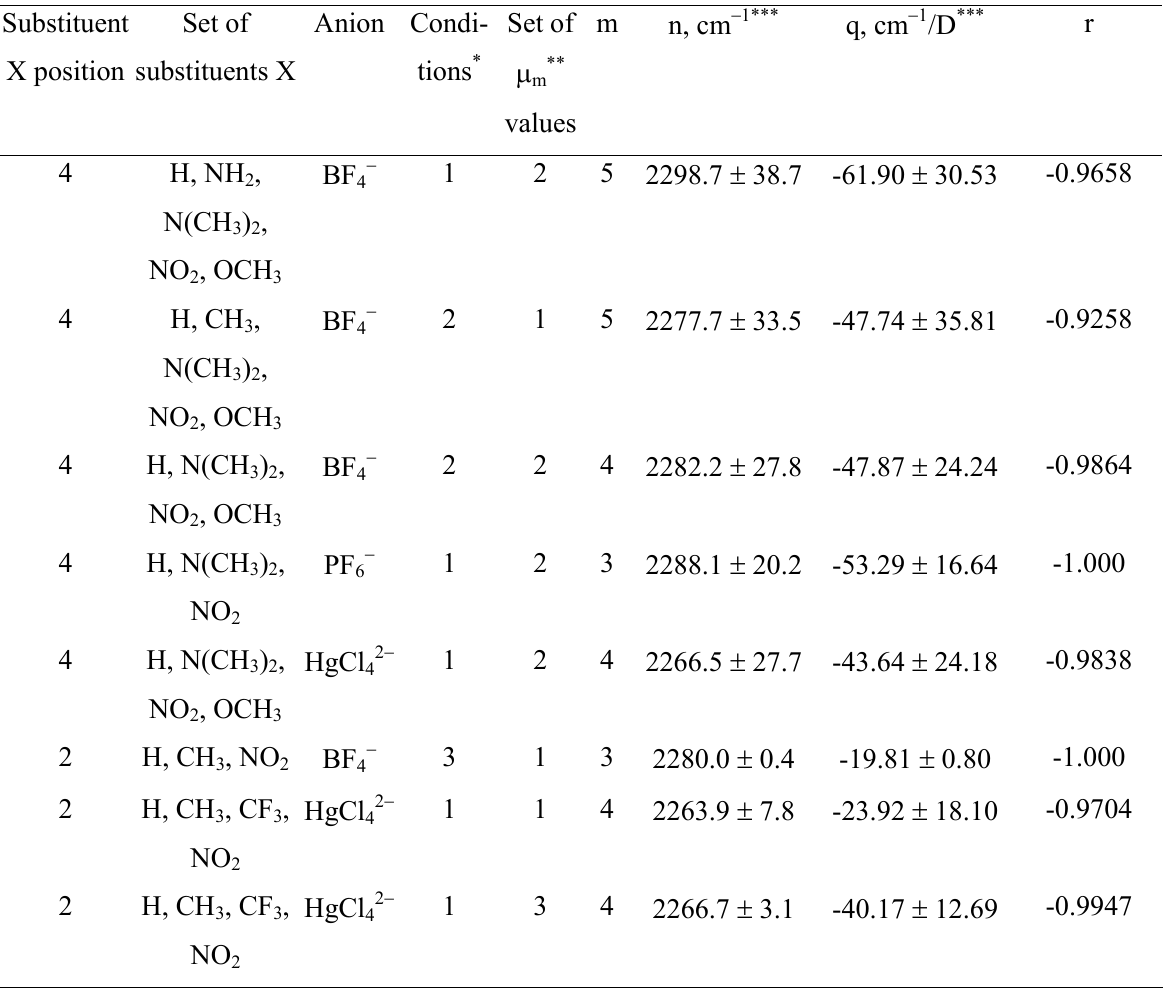
Table 4d. Correlations of stretching vibrational frequencies ( ν ) for fragment C-N + ≡ N bonds